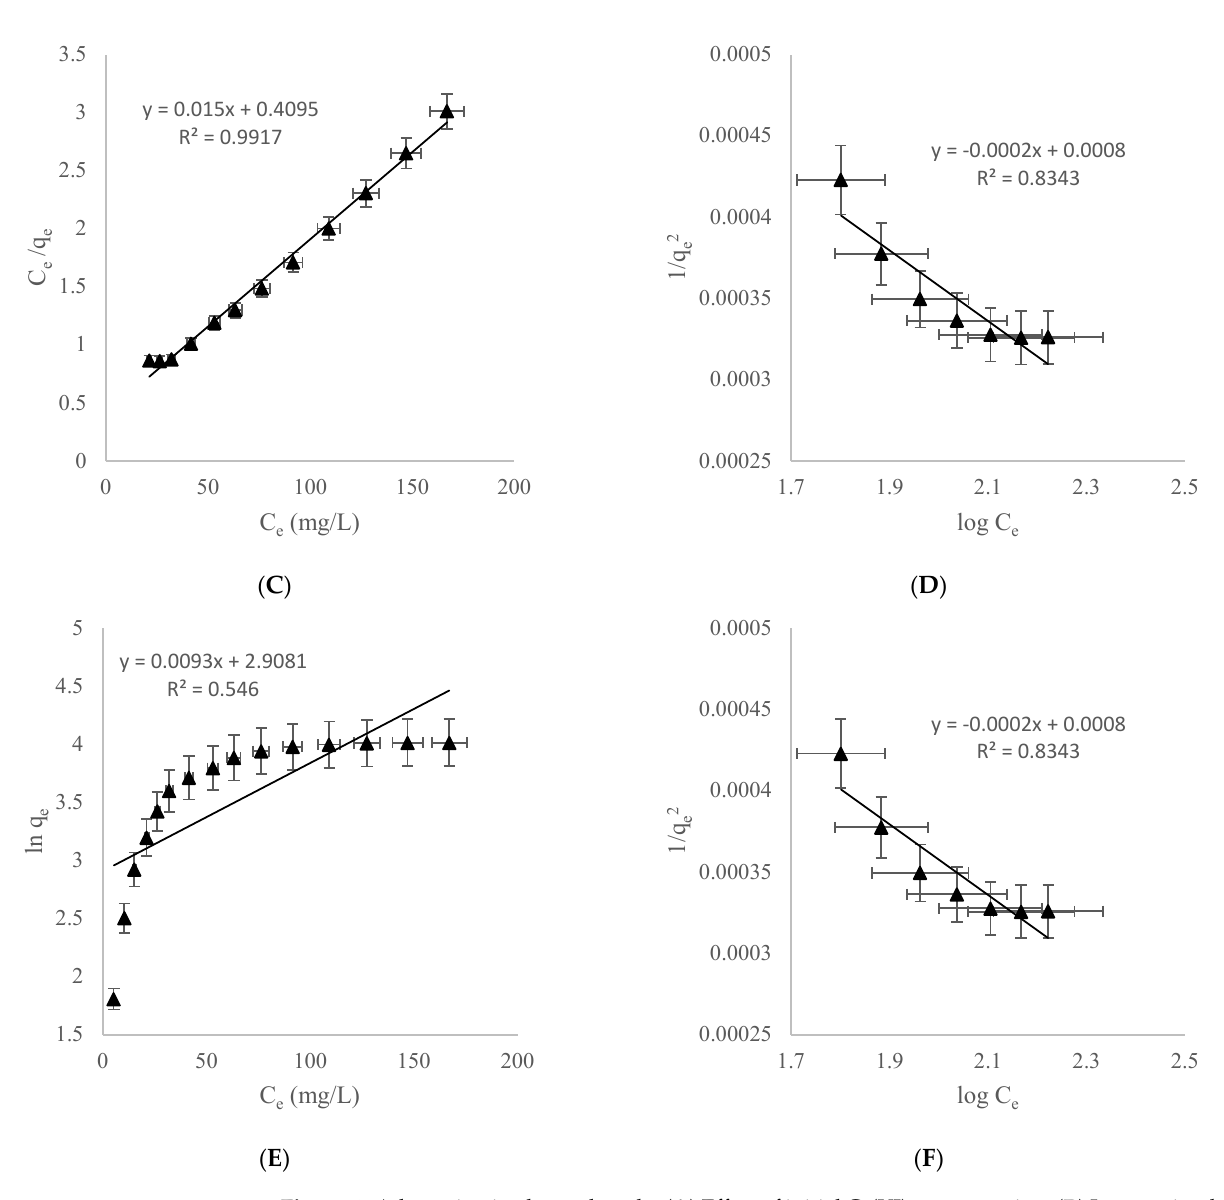
Figure 4. Adsorption isothermal study. ( A ) Effect of initial Cr(VI) concentration; ( B ) Langmuir adsorption isotherm; ( C ) Freundlich adsorption isotherm; ( D ) Temkin adsorption isotherm; ( E ) Jovanovic adsorption isotherm; ( F ) Harkins–Jura adsorption isotherm.